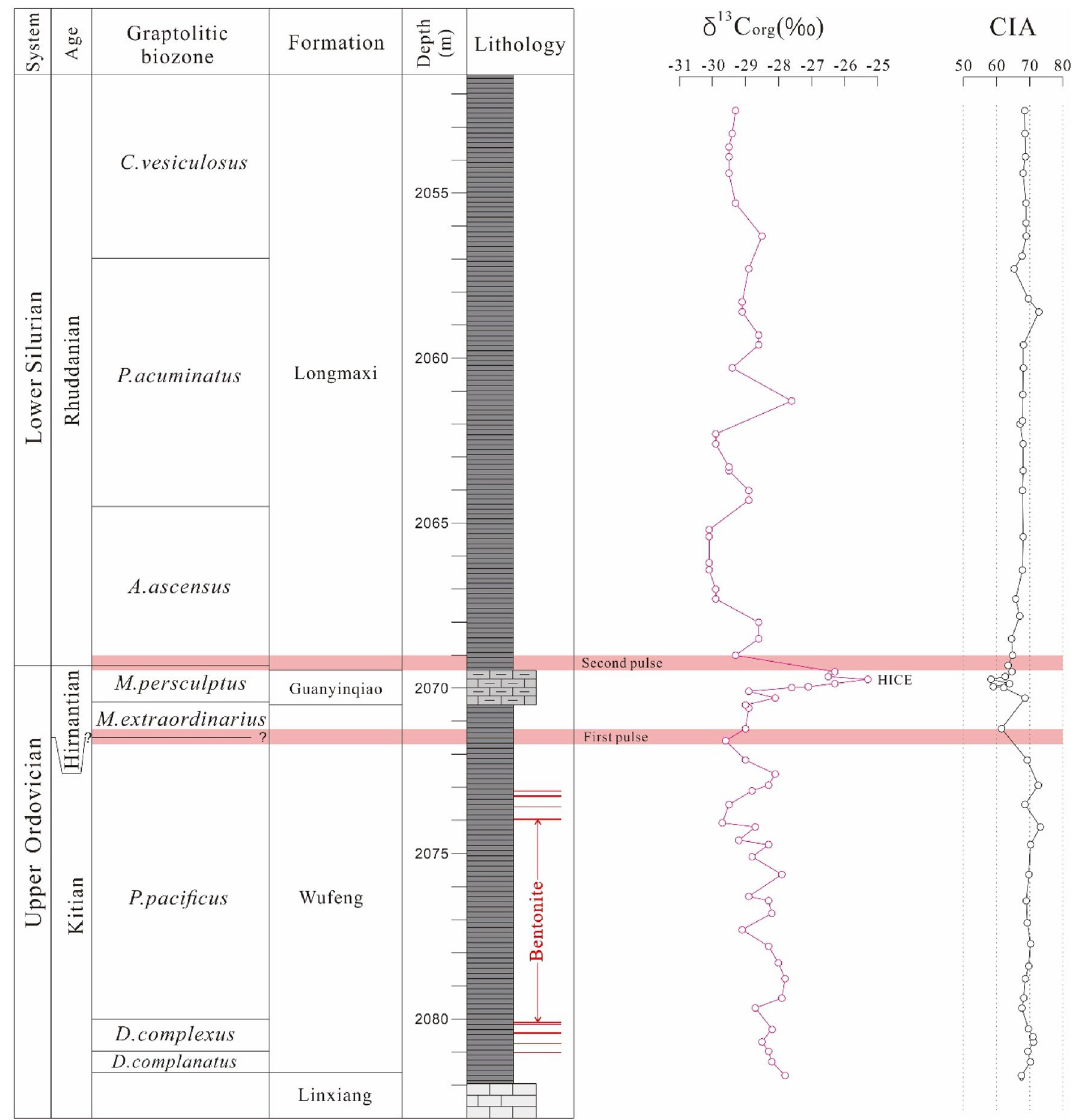
Figure 3. Biostratigraphic data, δ 13 C org profiles, and CIA values for the Xindi No. 2 well. The biostratigraphy is based on Zhang et al. 54 . HICE Hirnantian isotopic curve